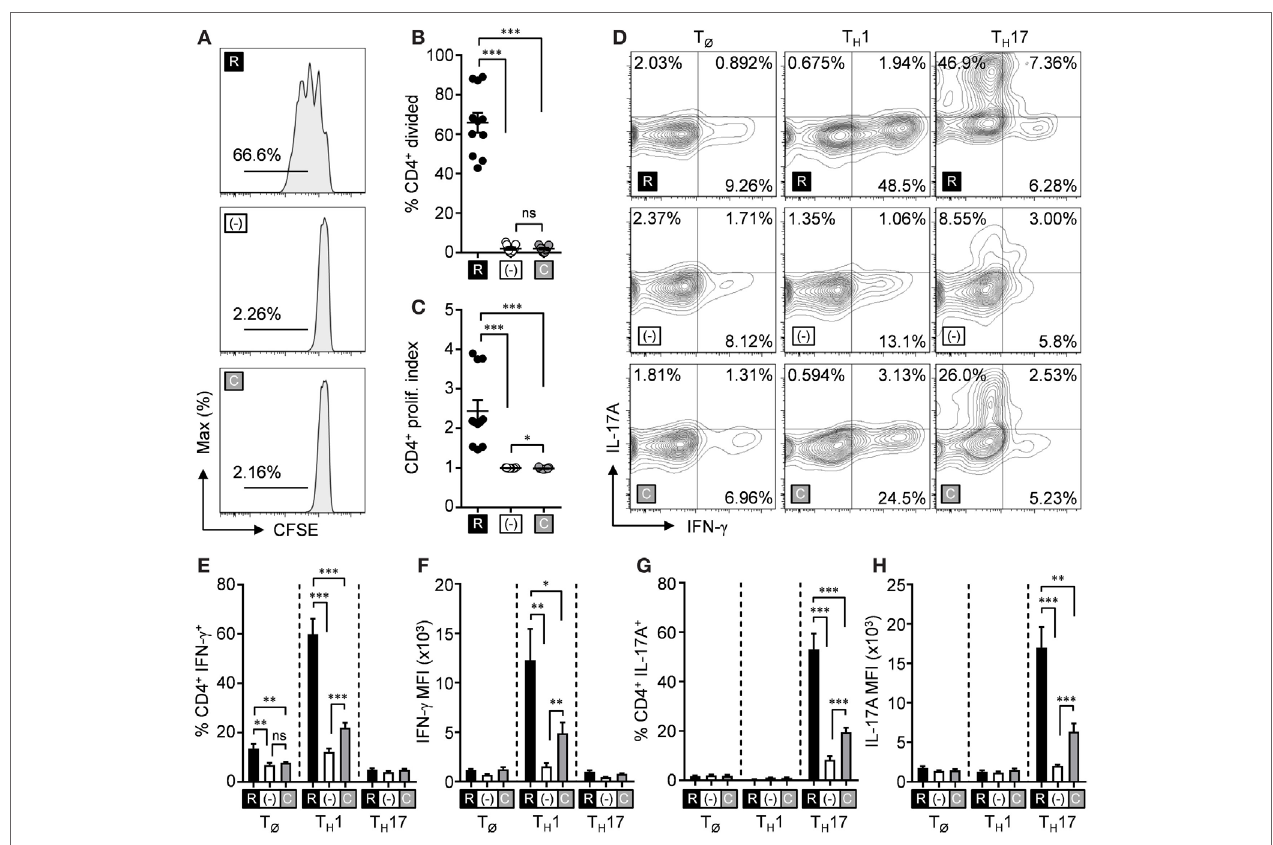
FigUre 2 | l - a rginine synthesis is necessary for l -citrulline-mediated T cell functions. (a–c) Lymphocytes from Asl flox/flox ;Tie2-cre mice were isolated and stained with carboxyfluorescein succinimidyl ester (CFSE). Cells were stimulated with α -CD3 and α -CD28 in R-free RPMI supplemented with 1 mM l -arginine (black), 1 mM l -citrulline (gray), or neither amino acid added (white) for 72 h. CFSE dilution of CD3 + CD4 + T cells was analyzed by flow cytometry. Data are displayed as representative histograms (a) , mean percent of divided cells (B) , and proliferation index (c) as defined in the methods. Data are combined from four experiments. (D–h) Lymphocytes from Asl flox/flox ;Tie2-cre mice were polarized under T Ø , T H 1, or T H 17 polarizing conditions for 5 days in the indicated culture conditions (see Materials and Methods). Following restimulation, cells were stained for intracellular cytokines and analyzed by flow cytometry. Cytokine-producing cells are represented in the graphs by single-positive, mean frequency of cytokine-expressing cells (e, g) , and mean fluorescence intensity of the indicated cytokine (F, h) . Data are combined from three experiments. Error bars, SEM. * p < 0.05, ** p < 0.01, *** p < 0.001 by Student’s t